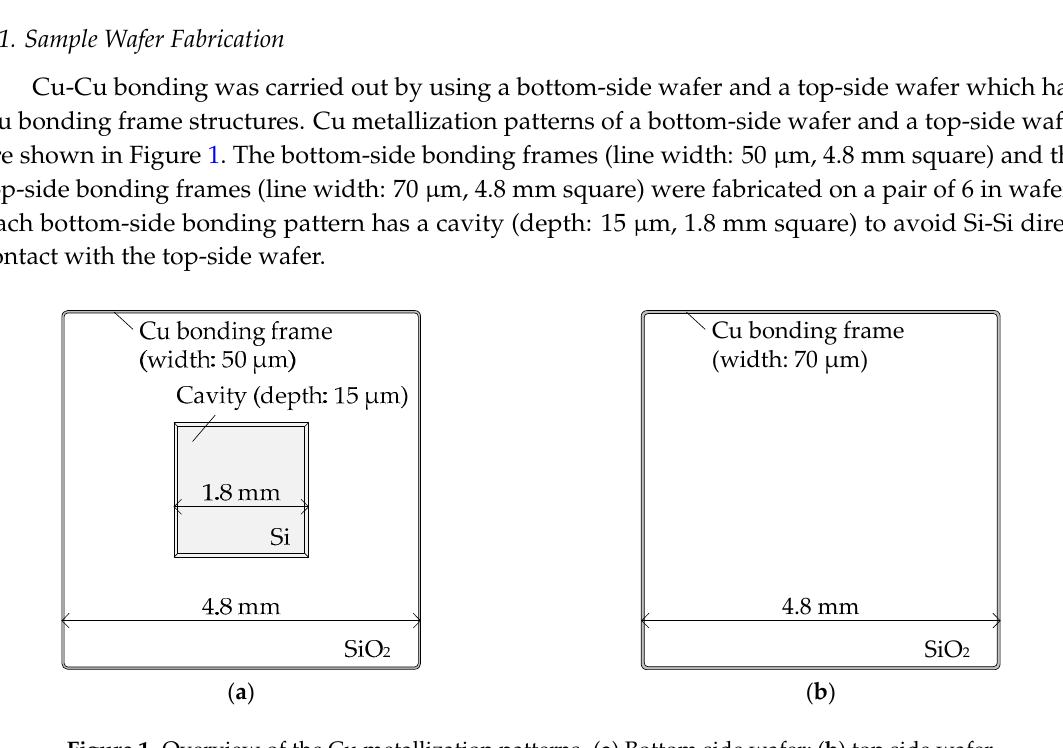
Figure 1. Overview of the Cu metallization patterns. ( a ) Bottom side wafer; ( b ) top side wafer.